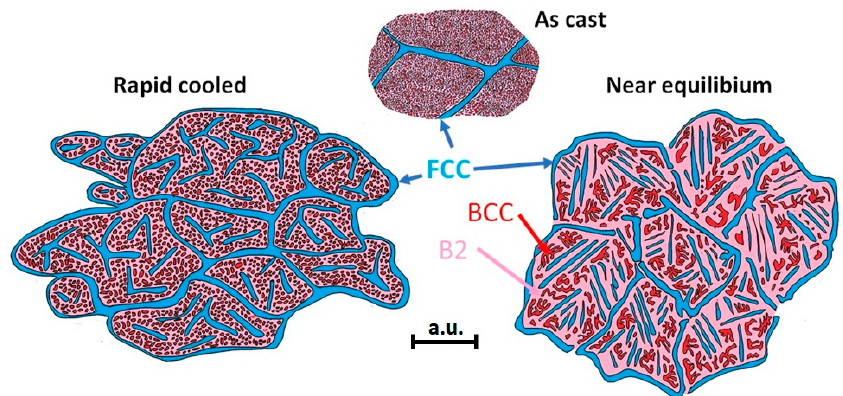
Figure 6. Microstructural approach through a schematic illustration (made from [24,51,53–59]) for the “as built” AlCoCrFeNi and EBMed near the equilibrium conditions and rapid cooled. The magnification mark is arbitrary due to the different papers used, but is in the range of 2–15 µm.